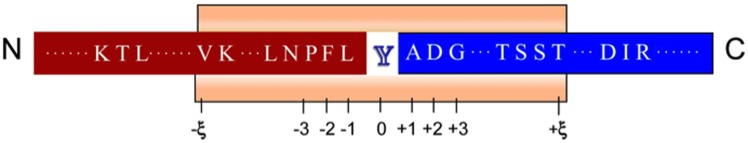
Illustration to show the peptide segment highlighted by sliding the scaled window

 along a protein sequence. During the sliding process, the scales on the window are aligned with different amino acids so as to define different peptide segments. When, and only when, the scale 0 is aligned with Y (tyrosine), is the  peptide segment seen within the window regarded as a potential nitrotyrosine peptide. Adapted from Chou [55], [77] with permission.